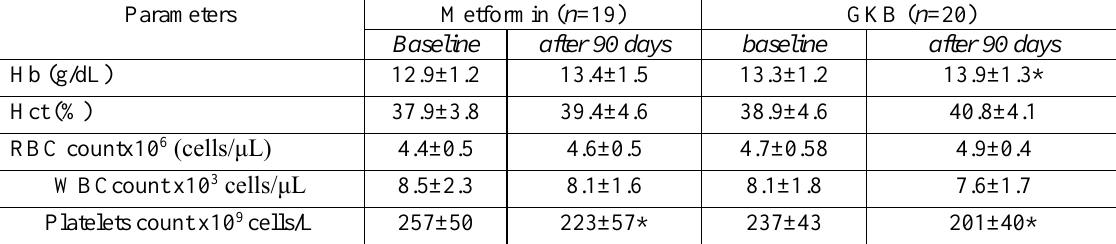
Table 4. Effect of Gingko biloba extract (GKB) on the hematological markers of patients with metabolic syndrome